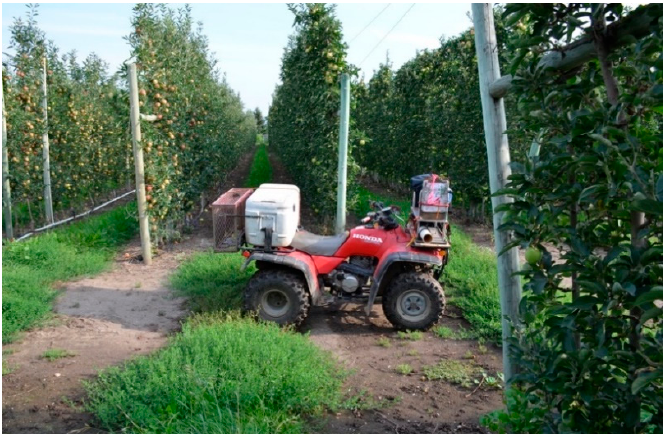
Figure 2. Photograph of a modified Honda Fourtrax all-terrain vehicle (ATV) used by the Okanagan– Kootenay Sterile Insect Release Program to release sterile codling moths ( Cydia pomonella ) in apple orchards. Moths are stored in a cooler on the rear of the ATV and released from the release device on the front of the vehicle (photograph by Tom Walker,